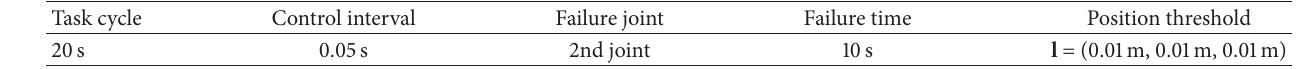
Table 2: Parameters for path planning task.